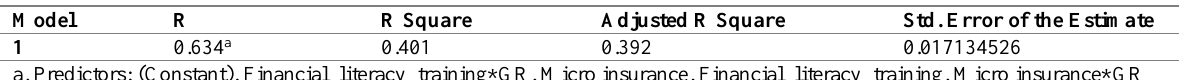
Table 11: Model Summary